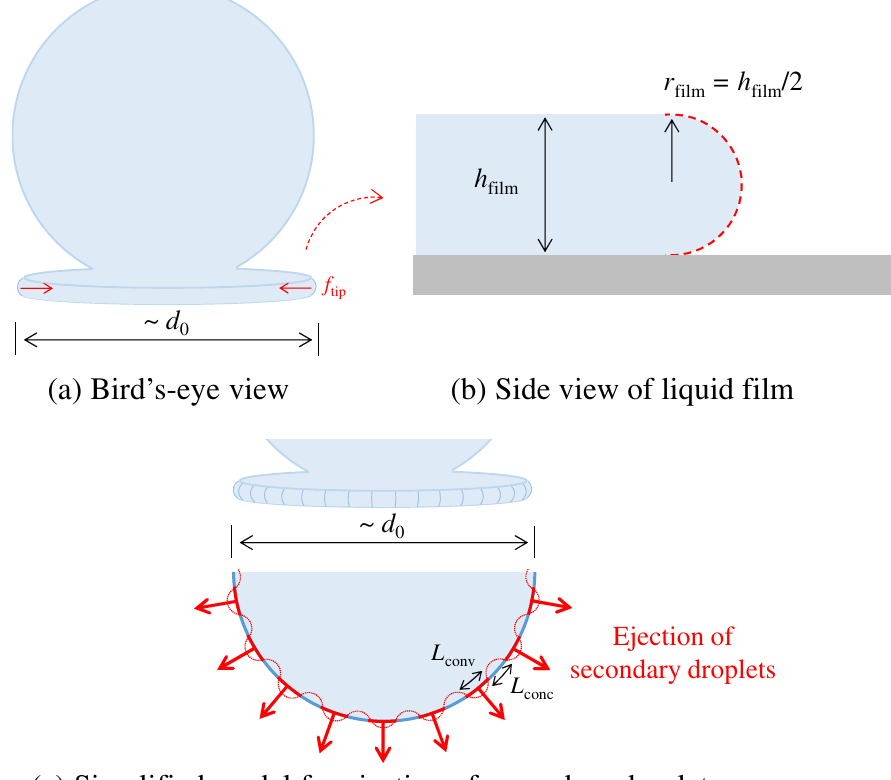
Figure 4. Schematic of the simplified model for liquid film behaviour in droplet impingement. (a) The droplet and liquid film at a moment in the impingement. The surface tension exerted on the tip of the liquid film is expressed as f tip . (b) Side view of the tip of the liquid film with the thickness of h film , and the tip shape is characterised by a part of circle whose radius is r film (= h film / 2). (c) Circumferential instability of the liquid film is simplified, and the diameter of the disc-like liquid film is characterised by d 0 . L conv and L conc are the arc lengths of the concave and convex parts projected on the circumference. The secondary droplet is assumed to eject from every convex position along the circumference (red bold